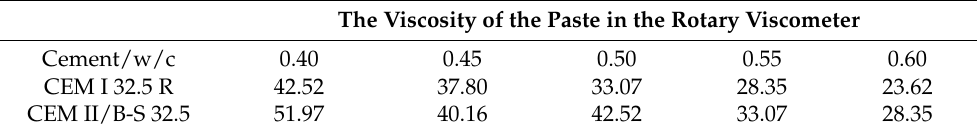
Table 3. The viscosity of the paste in the rotary viscometer. The Viscosity of the Paste in the Rotary Viscometer